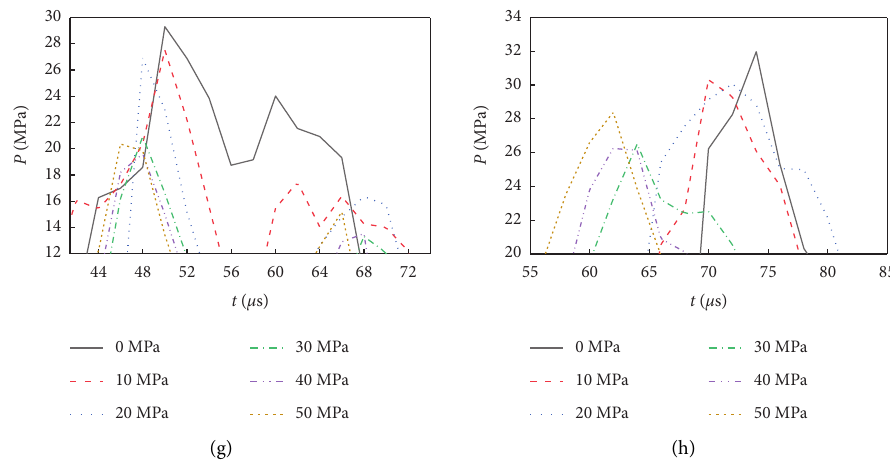
Figure 8: Stress-time curve of measuring points at different distances under two-way different pressure. (a) d � 5 cm. (b) d � 10 cm. (c) d � 15 cm. (d) d � 20 cm. (e) d � 5 cm. (f) d � 10 cm. (g) d � 5 cm. (h) d � 10